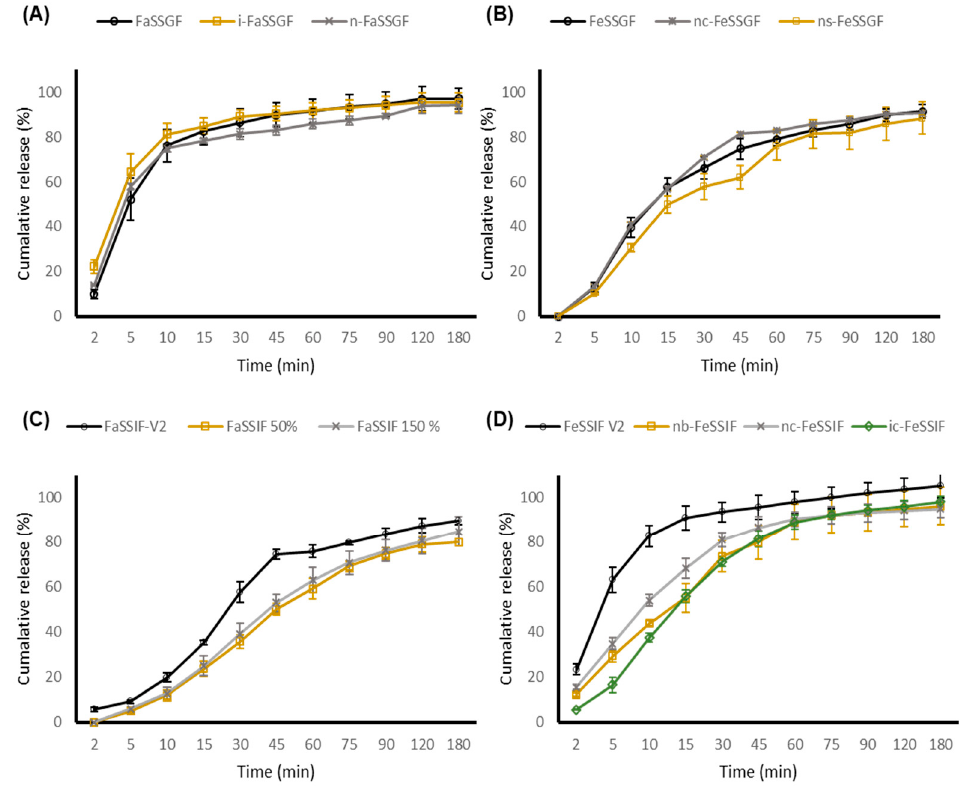
Figure 2. Dissolution profile of carvedilol 0.5 mg ODMT in adult and paediatric biorelevant media. Data presented as mean ± standard deviation ( n = 6). ( A ) FaSSGF = Adult Fasted-state Simulated Gastric Fluid, ( B ) FeSSGF = Adult Fed-state Simulated Gastric Fluid, ( C ) FaSSIF-V2 = Adult Fasted- state Simulated Intestinal Fluid, and ( D ) FeSSIF = Fed-state Simulated Intestinal Fluid. i = infant, n = neonate, c = cow-based milk formula, s = soy-based milk formula, and b = breast fed.